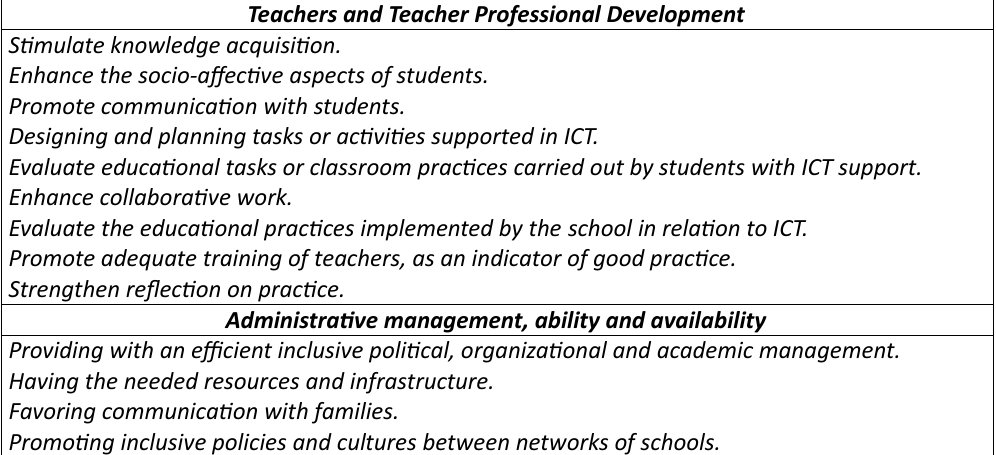
Table 3. Factors favoring good educational